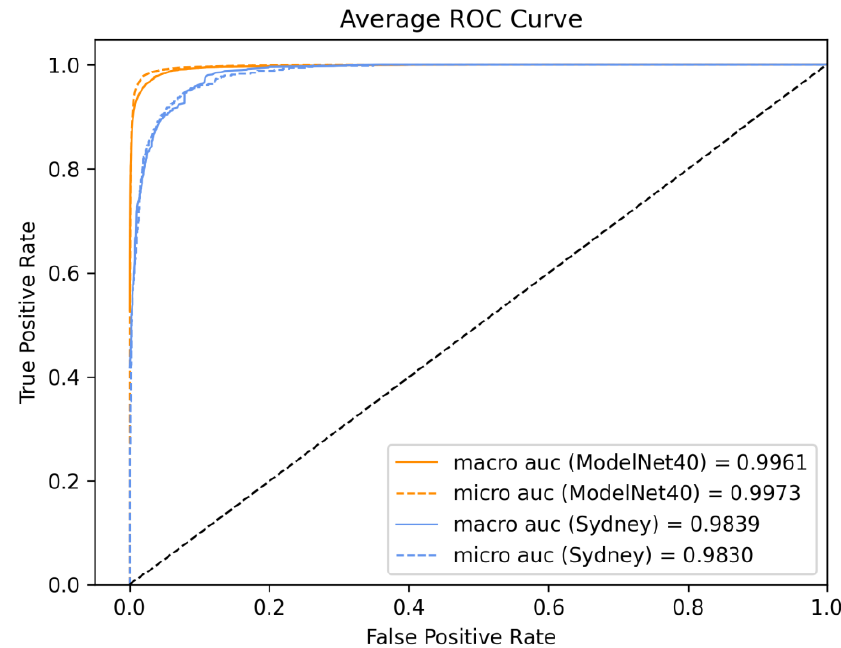
Figure 10. Average ROC curve for all classes on two datasets.